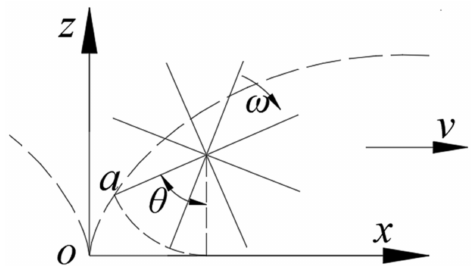
Figure 3. Schematic diagram of convex hull movement in